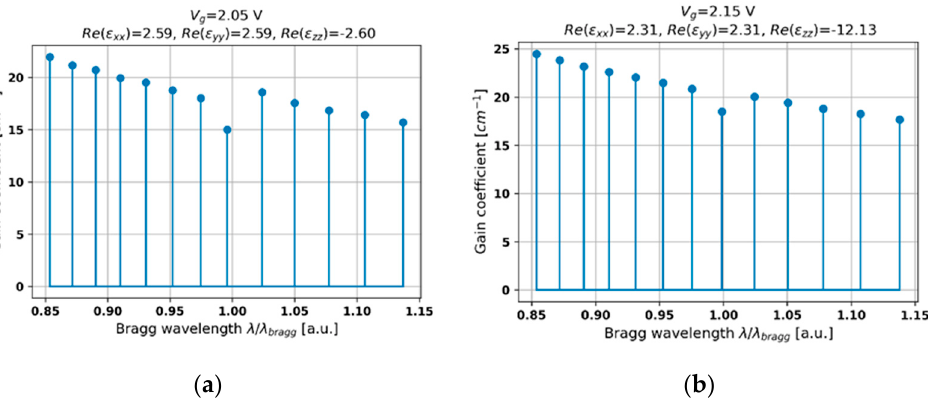
Figure 6. Threshold modal spectra for PHC structures with HMM structures revealing type I hyperbolic dispersion and biased with external voltage V g = 2.05 V ( a ) and 2.15 V ( b ).